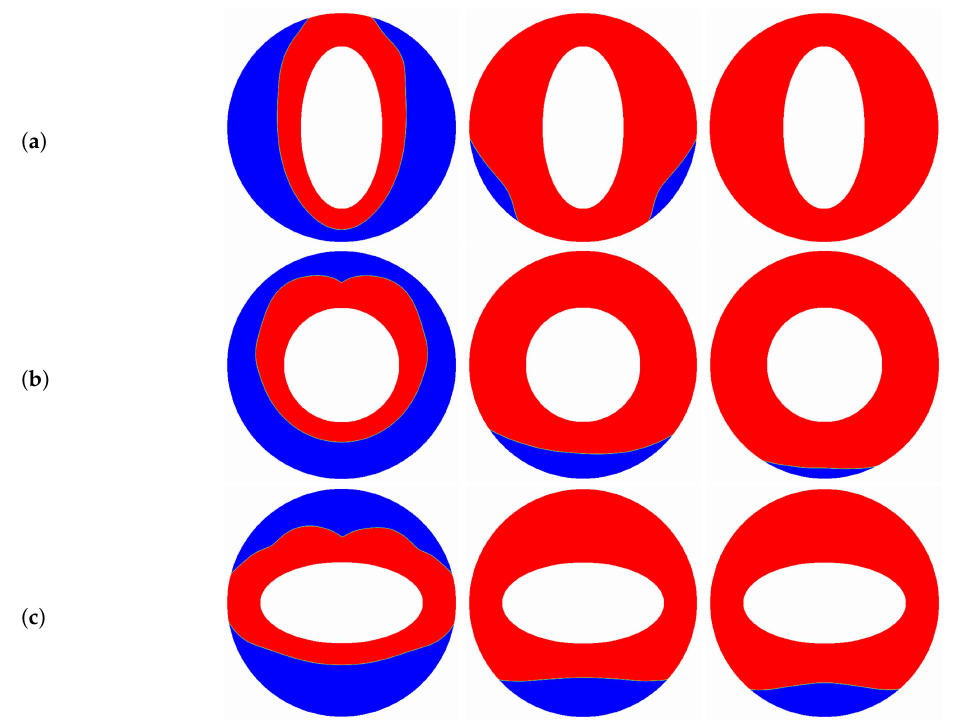
Figure 11. The transient distributions of the solid-liquid interface for different aspect ratios (( a ) AR = 1/2; ( b ) AR = 1; ( c ) AR = 2) at Fo = 1.0, 5.4 and 8.2, in which Ra = 10 5 , T =